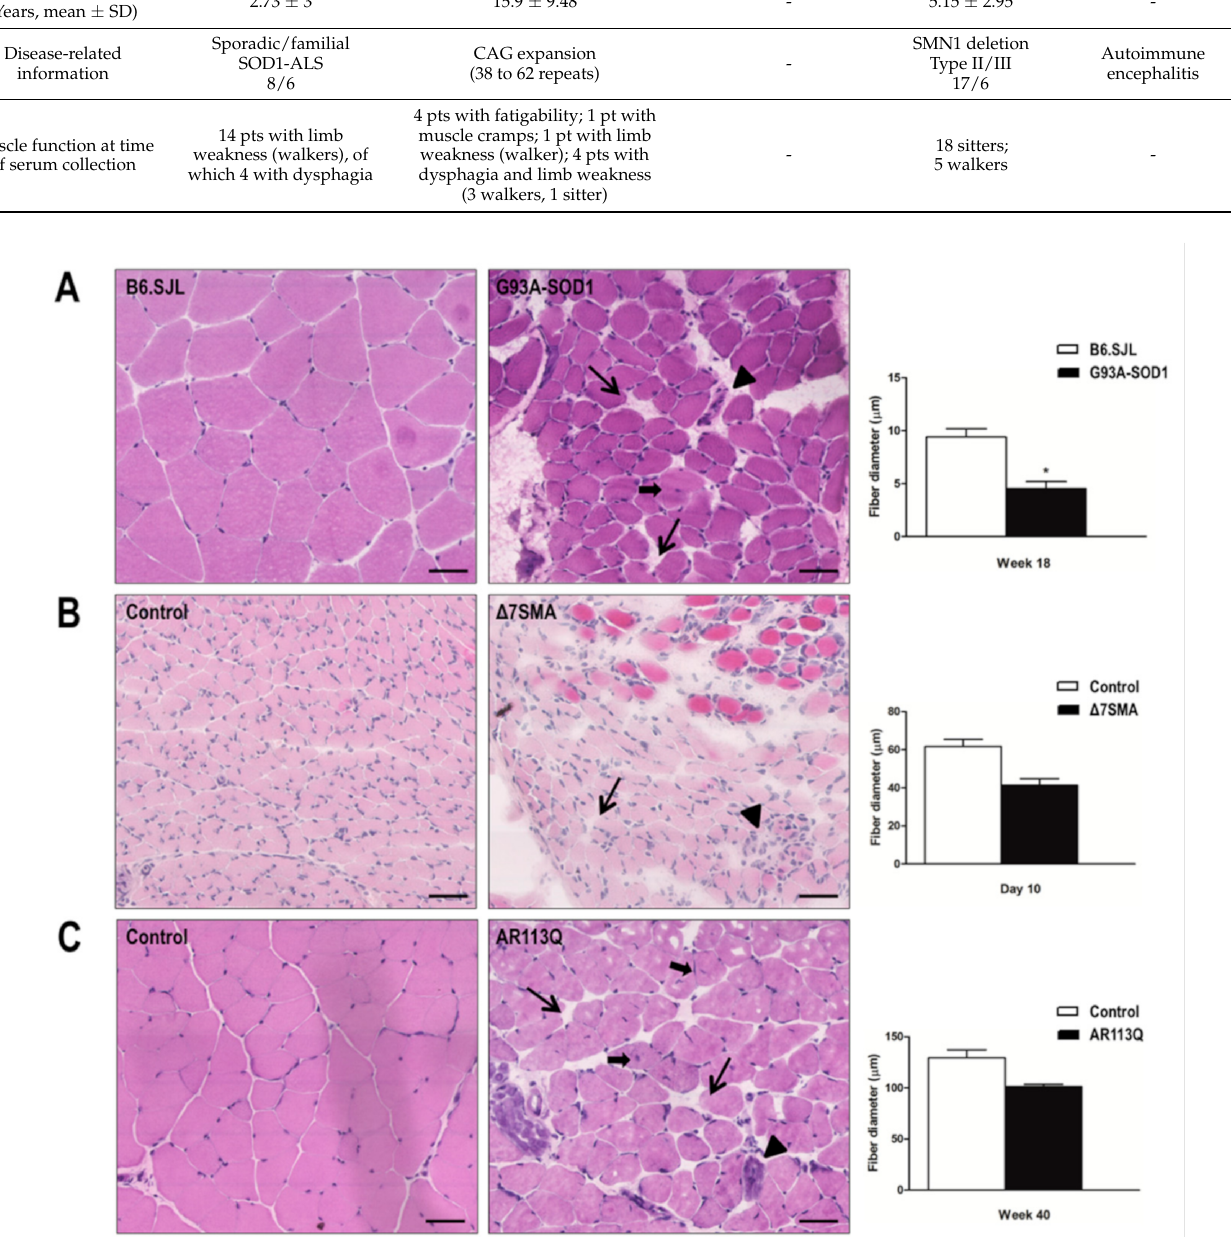
Figure 6. Histological analysis of gastrocnemius muscle fiber diameter in G93A-SOD1, ∆ 7SMA, and AR113Q mice. Representative transversal skeletal muscle sections stained with hematoxylin/eosin in (right column) ( A ) G93A-SOD1 mice, ( B ) ∆ 7SMA mice, and ( C ) AR113Q mice at late disease stages (week 18, day 10, and week 40, respectively), and relative age-matched controls (left column). Long arrows indicate enlarged endomysial spaces; arrowheads indicate degenerating cells with apoptotic fragmented nuclei; short arrows indicate fibers with centrally located nuclei, common during muscle regeneration. Magnification 40X. Scale bar = 50 µ m. On the right, measurement of fiber diameter in gastrocnemius muscle of G93A-SOD1 at week 18 (black bars), ∆ 7SMA mice at day 10 (black bars), AR113Q mice at week 40 (black bars), and relative age matched control mice (white bars). Each histogram represents the mean diameter ( µ m) ± SEM of muscle fibers measured in three muscle sections per mouse from three mice in each group. * p < 0.05. Mann–Whitney